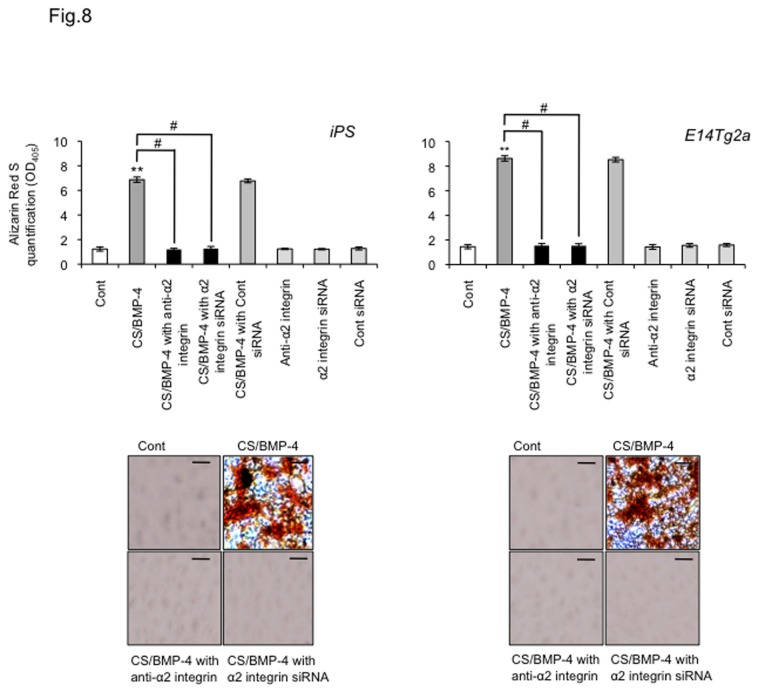
Effect of anti-integrin α2 mAb and siRNA on mineralization capacity in odontoblast-like cells.Cells were prepared as in A and cell mineralization was assessed by Alizarin Red-S (ARS) staining, with quantification performed by measuring absorbance at 405nm. Data are the mean ± SD (n=4). **P < 0.01, vs. control; #P < 0.01, as indicated by brackets.